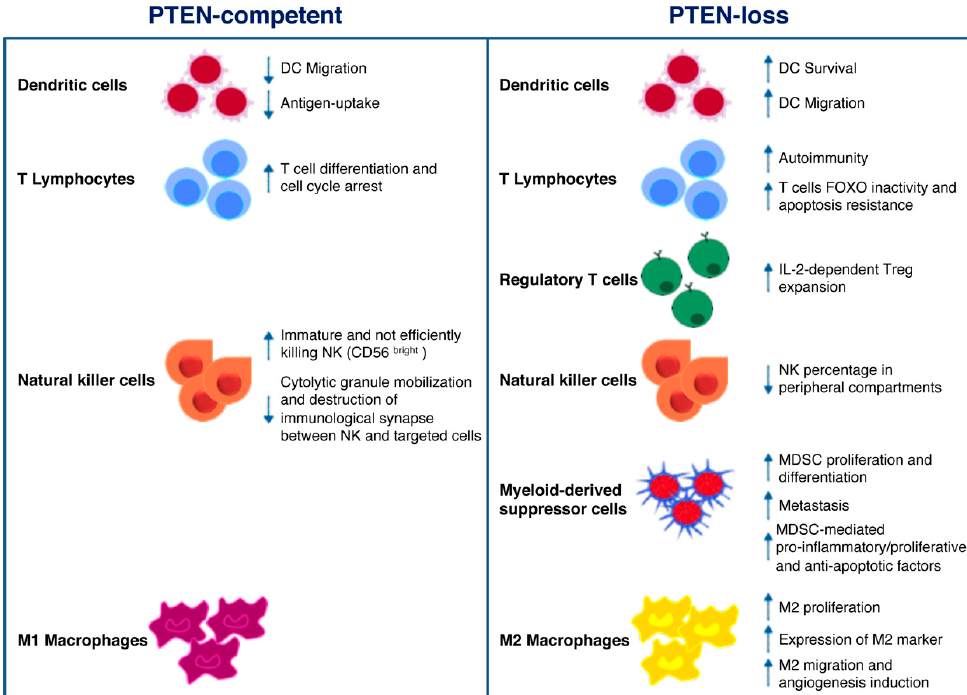
Figure 1. Schematic illustration of phosphatase and tensin homolog on chromosome 10 (PTEN) function in immune cells. PTEN modulates several microenvironmental stimuli and immune cells processes, according to the cell type in which it is expressed ( left panel ) or not. As for cancer cells, the lack of PTEN activity mainly correlates with immune escape mechanisms and protumoral immune cells infiltration/expansion ( right panel ).